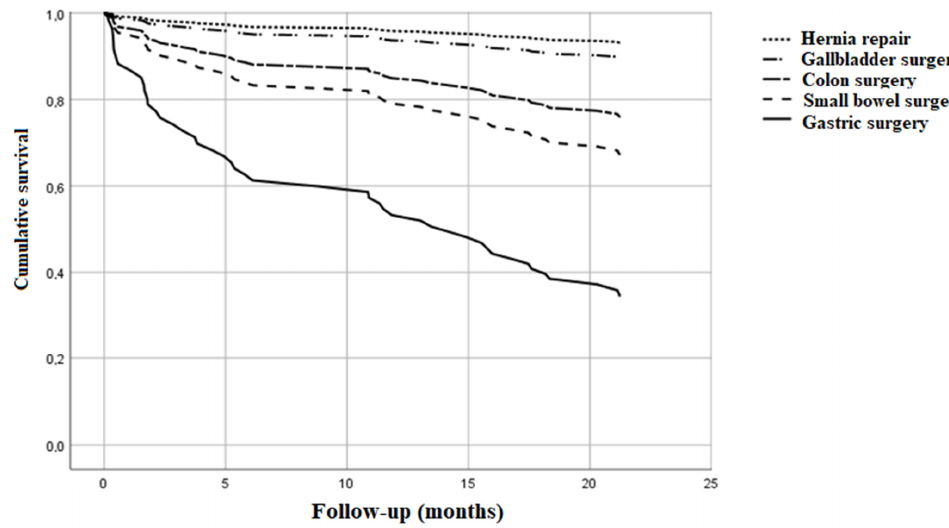
Figure 1. Cumulative survival of individuals undergoing emergency abdominal surgery by the type of surgery. None of the subjects undergoing appendectomy died during follow-up. Table 1. Clinical features of patients undergoing emergency abdominal surgery that survived and deceased.